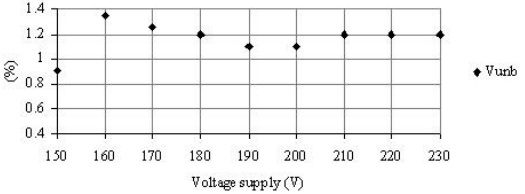
Figure 4. Unbalance factor for voltages V unb depending on the supply voltages (set 1).